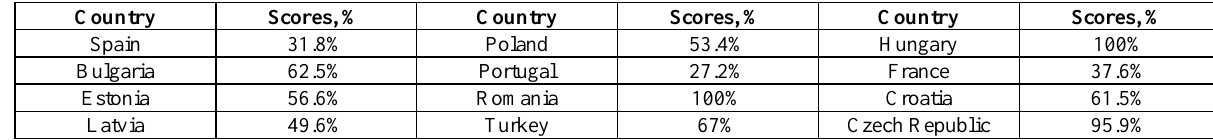
Table 3. Countries’ distribution by the level of new registered enterprises (for the 1st group of the 2nd cluster)